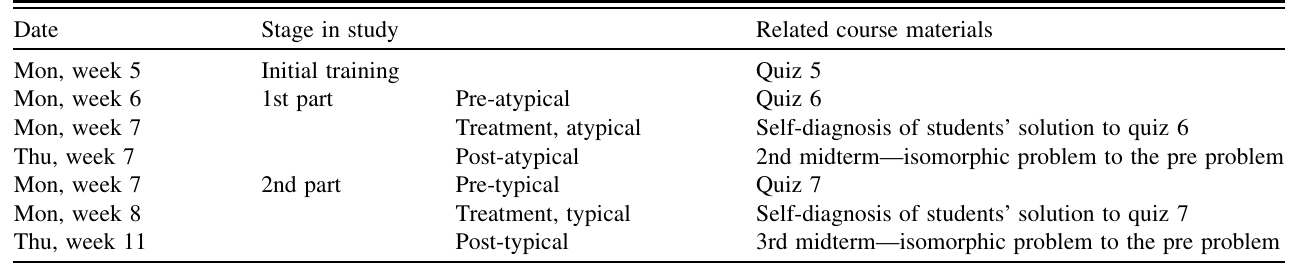
TABLE I. Experimental